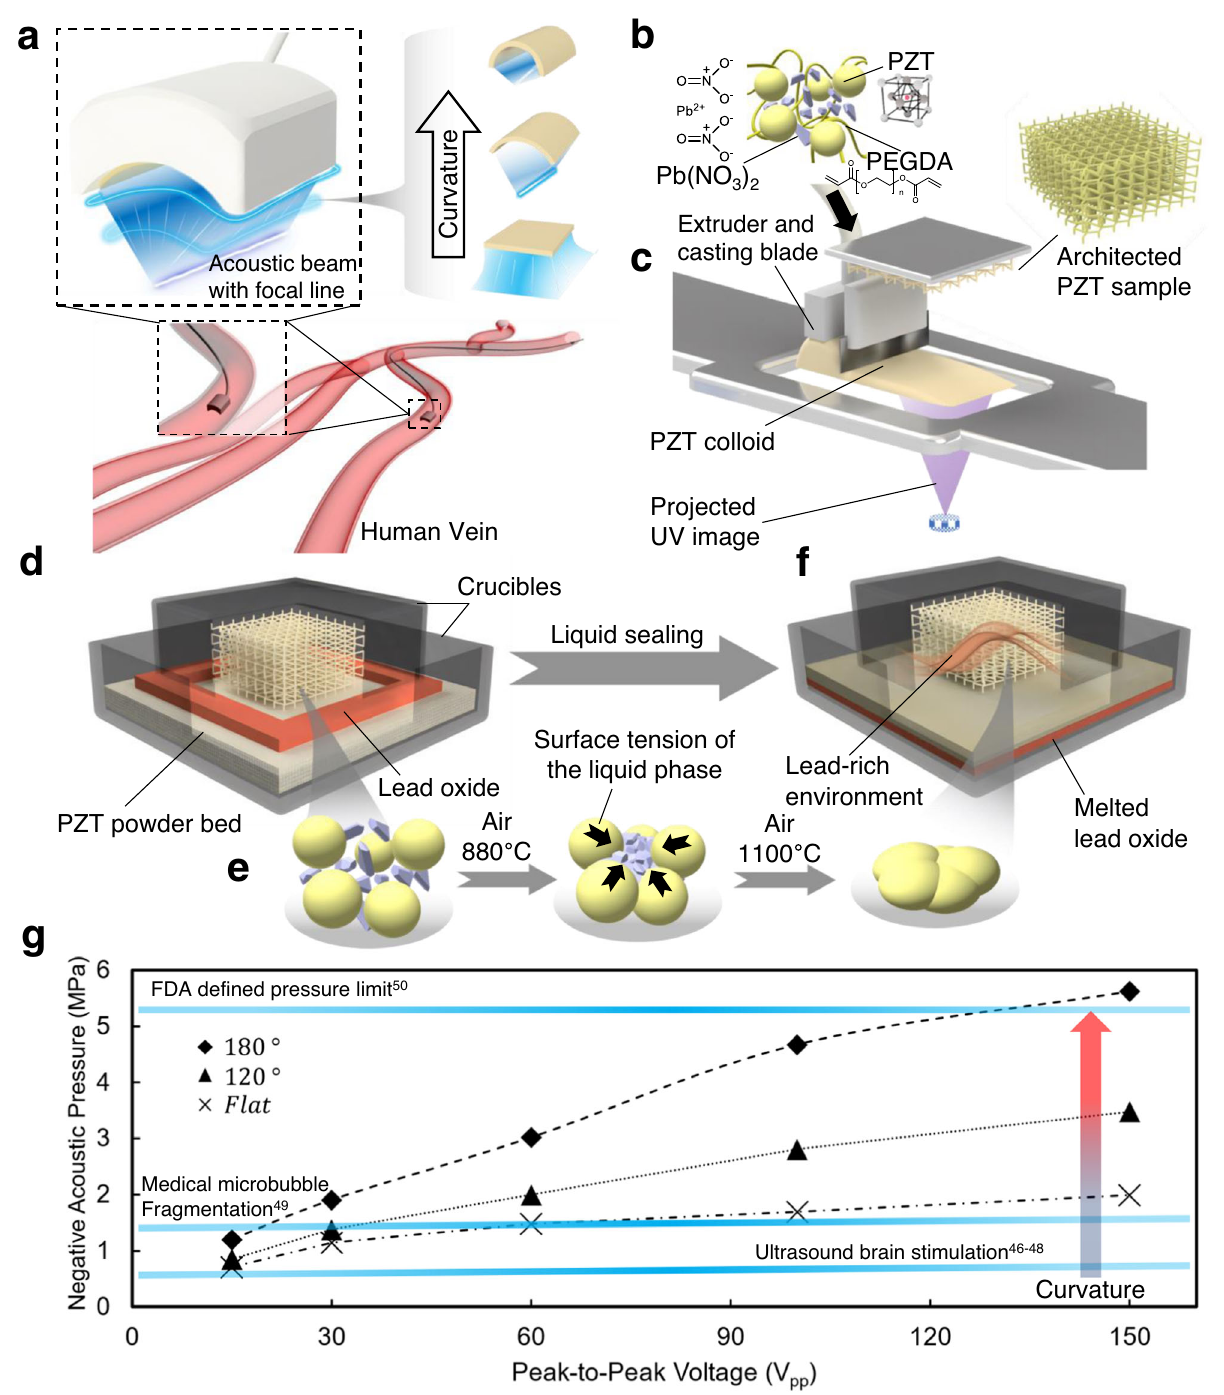
Fig. 1 | Miniatured ultrasound transducer design and 3D printing of a highly loaded PZT compositeand liquid phase sintering. a Schematicof the fabricated miniatured ultrasound transducer with curved PZT elements. b Schematic of the liquid sintering resin components. c Novel 3D printing system for liquid phase sinteringpiezoelectriccomposites. d Debondingprocesstoburnoffthesupportive